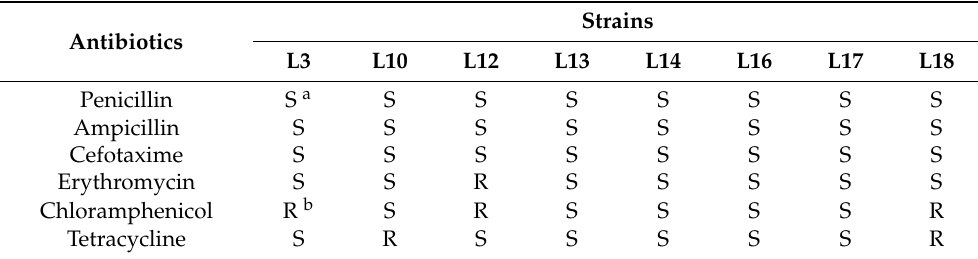
Table 5. Antibiotic susceptibility of selected 8